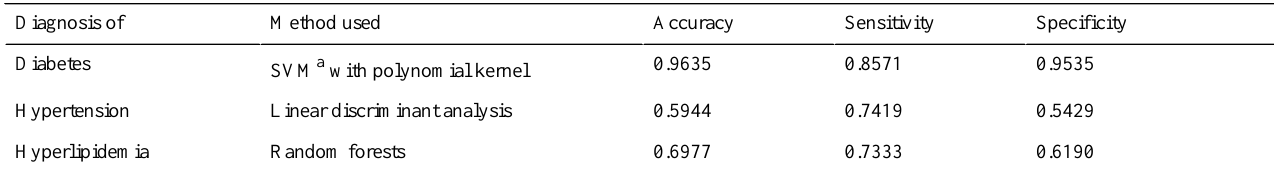
Table 6. Algorithm